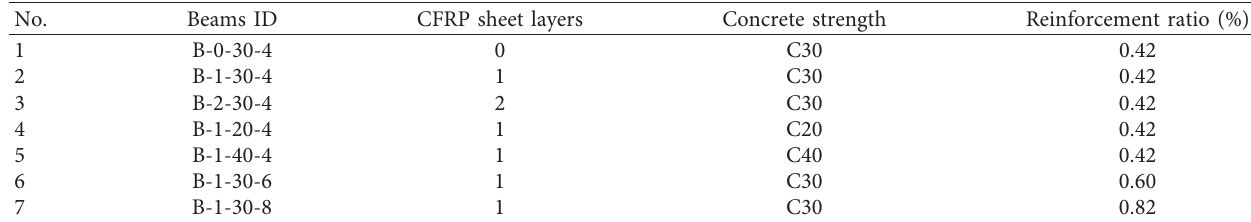
Figure 2: Specimen reinforcement (unit: Table 1: Design parameters of the specimen.